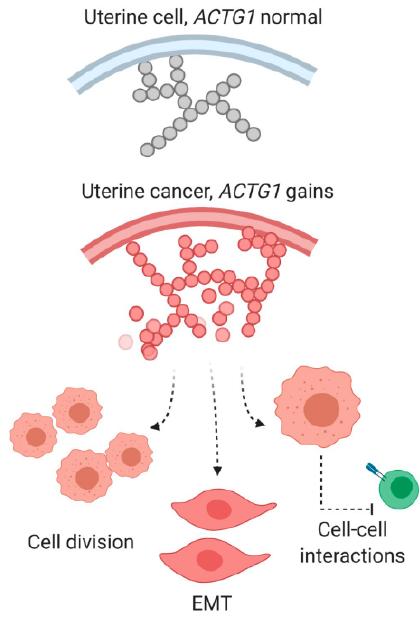
Figure 7. ACTG1 function and consequences of its gains are depicted in uterine cancers subtypes.